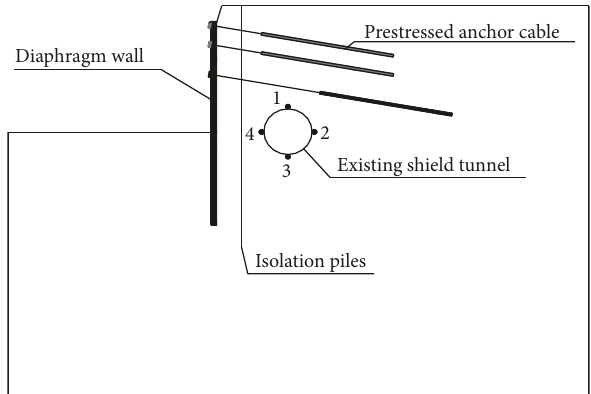
Figure 11: Layout of monitoring points for horizontal displace- ment of the tunnel structure.